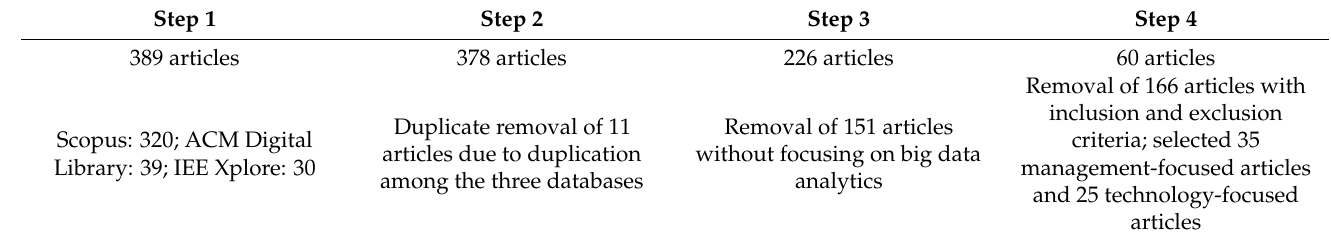
Table 3. Four steps of study selection and